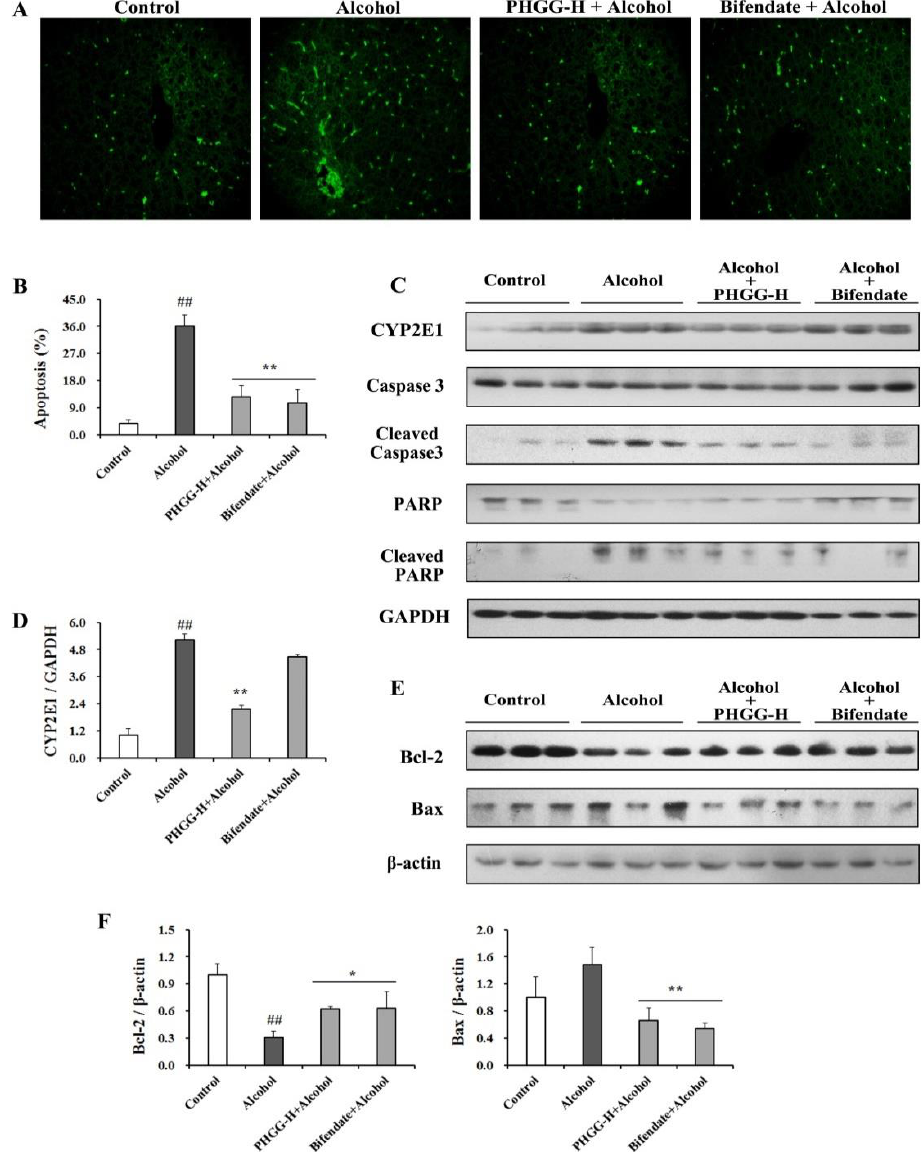
Figure 5. E ff ect of partially hydrolyzed guar gum (PHGG) on alcohol-induced apoptosis in liver tissues. ( A ) Terminal deoxynucleotidyl transferase mediated d-UTP nick end labeling (TUNEL) staining of liver tissues from alcohol intoxicated mice with / without PHGG protection. ( B ) Apoptosis of liver tissues from alcohol intoxicated mice with / without PHGG protection. ( C ) Western blot images of cytochrome P450 2E1 (CYP2E1), Caspase 3, and PARP in ALD mouse with / without PHGG protection. ( E ) Western blot images of Bcl-2 and Bax protein expression in liver tissues from alcohol intoxicated mice with / without PHGG protection. Beta-actin and GAPDH were used as loading control. Densitometric blots of CYP2E1 ( D ), Bcl-2, and Bax ( F ) were produced by measuring protein band density using ImageJ software. Liver tissues were collected from mice of the Control group, Alcohol group, PHGG-H + Alcohol group, and Bifendate + Alcohol group. Results are shown as mean ± SD ( n = 3) of three independent experiments. “##” ( p < 0.01), significantly di ff erent when compared to the Control group. “*” ( p < 0.05) and “**” ( p < 0.01), significantly di ff erent when compared to the Alcohol group. PHGG-H + Alcohol: PHGG high dose + alcohol group, treated with 2000 mg / kg · day of PHGG plus